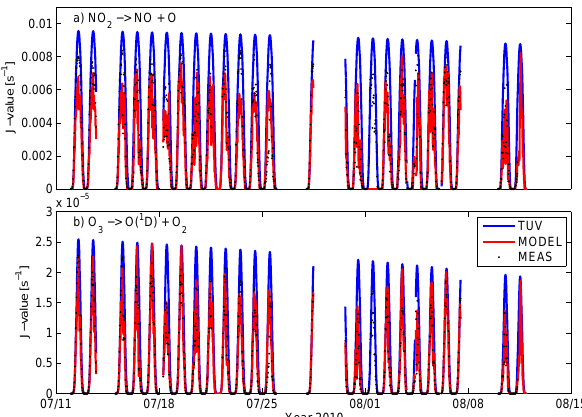
Figure 7. Above-canopy measured (black dots) and SOSAA mod- elled (red line) photolysis rate for (a) NO 2 → NO + O and (b) O 3 → O ( 1 D ) + O 2 . For comparison, also the TUV (Tropospheric Ultravi- olet and Visible Radiation Model) predicted rates are included.